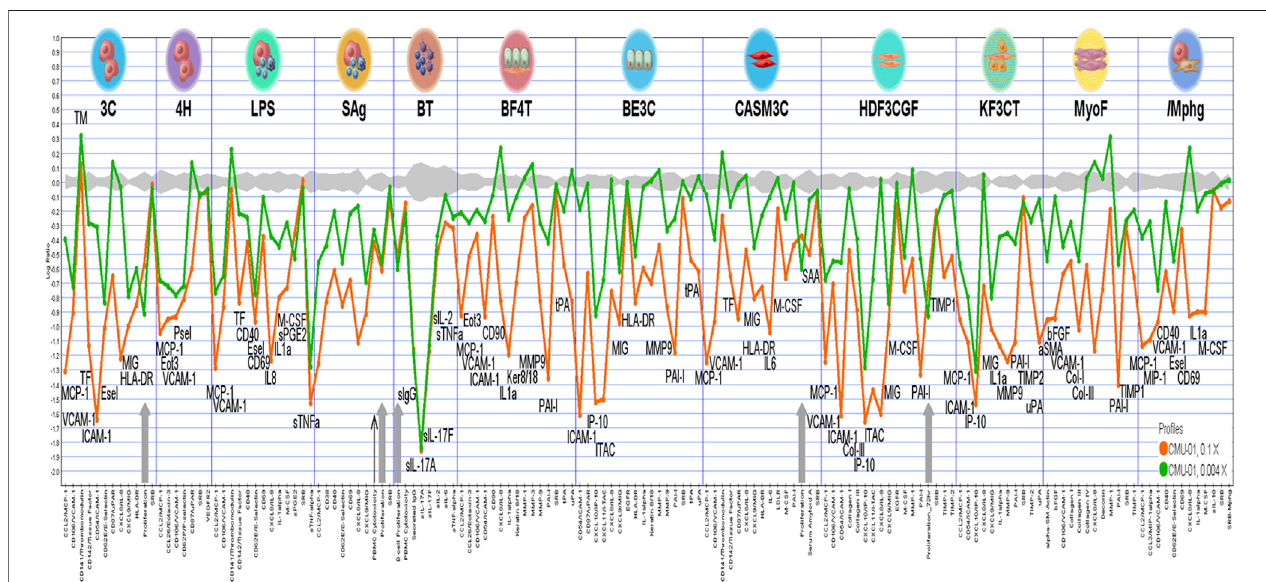
FIGURE 2 | The analysis of bioactivities in each BioMAP assay systems. The cytotoxic and anti-proliferative activities are illustrated by thin black arrow and grey arrows,